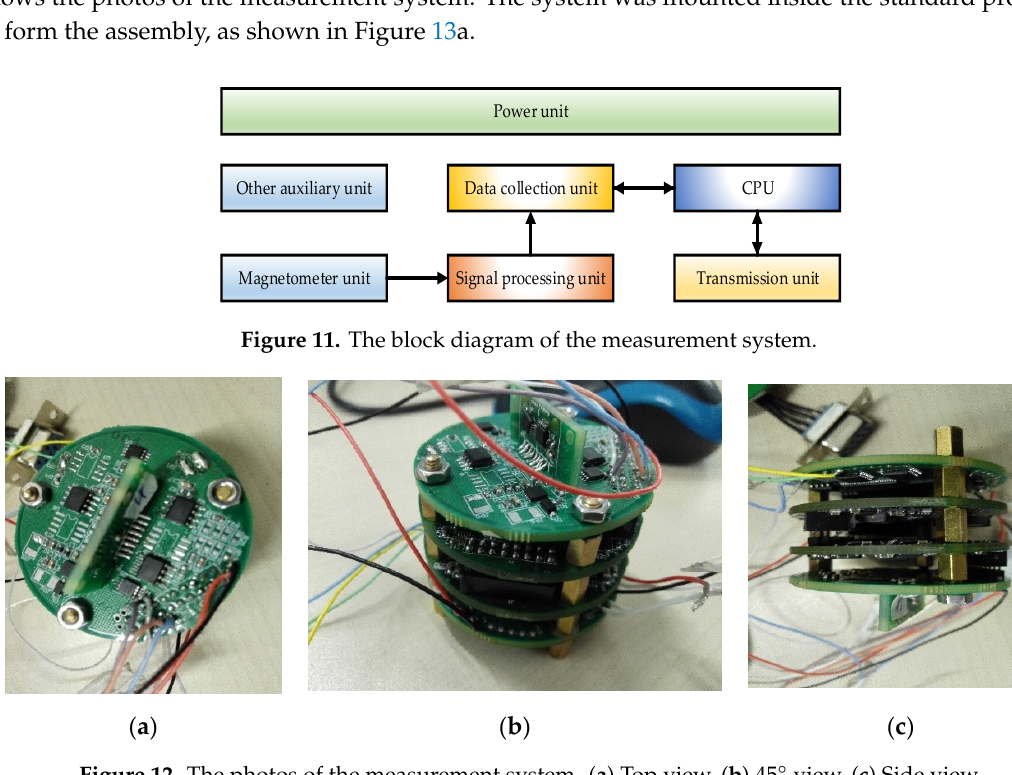
Figure 12. The photos of the measurement system. ( a ) Top view, ( b ) 45° view, ( c ) Side view